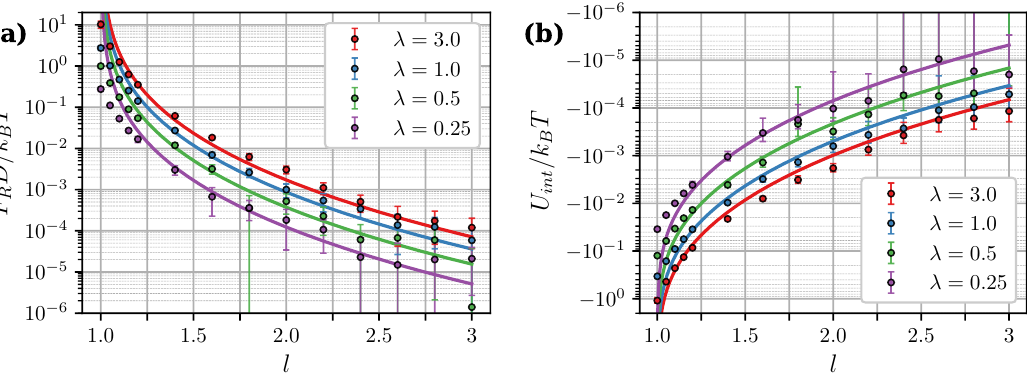
Figure 5. ( a ) Zero-field magnetic force and ( b ) interaction energy of two clusters as a function of the intercluster separation. ξ = 0, ϕ = 0.3. Different colors correspond to different λ (see legend). Symbols are simulation results for N = 100. Curves are predictions of the Lifshitz theory [Equations (19)–(21)] combined with MMFT [Equation (18)]. An assumption U int = 2 W was used to obtain theoretical curves in ( b )